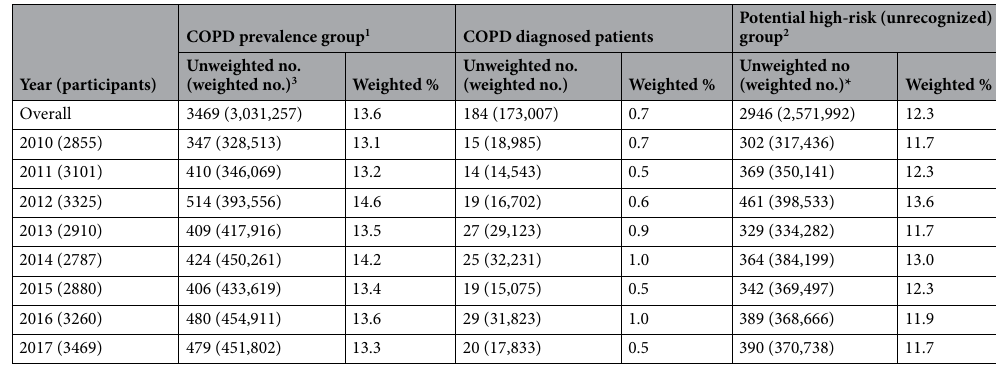
Table 1. Prevalence of COPD, diagnosed patient, and potential high-risk group in 2010–2017. COPD chronic obstructive pulmonary disease, FEV 1 forced expiratory volume in 1 s, FVC forced vital capacity. 1 Participants with FEV 1 /FVC < 0.70. 2 Excluded those diagnosed with COPD, tuberculosis, asthma, and lung cancer in COPD prevalence. 3 Estimated number of people reflecting actual population.